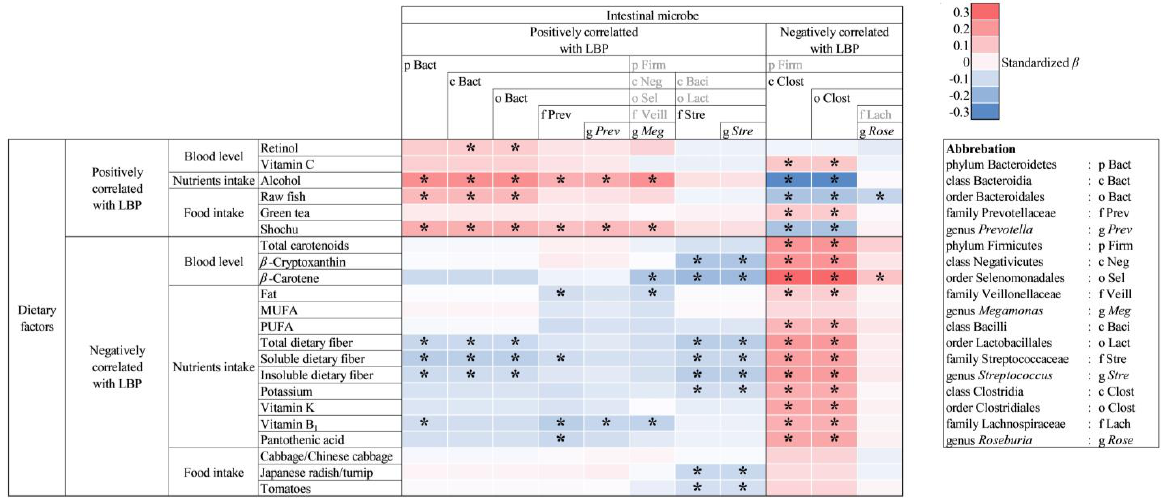
Figure 1. Heatmap showing the relationship between dietary factors and intestinal microbiota which were correlated with plasma LBP concentration. Each intestinal bacterium was listed accord- ing to bacterial classification, and bacteria not used in the analysis were indicated by gray letters. Standardized β was shown in red (positive correlation) or blue (negative correlation). False discov- ery rates were evaluated by Storey method. * Q < 0.20.